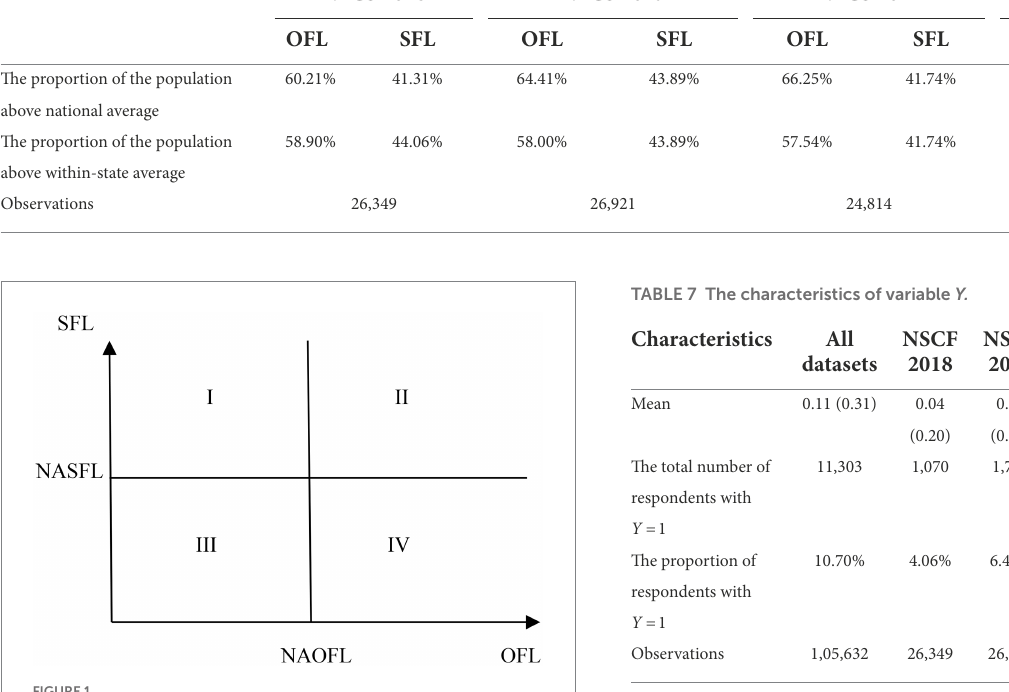
FIGURE 1 The four cases of states.